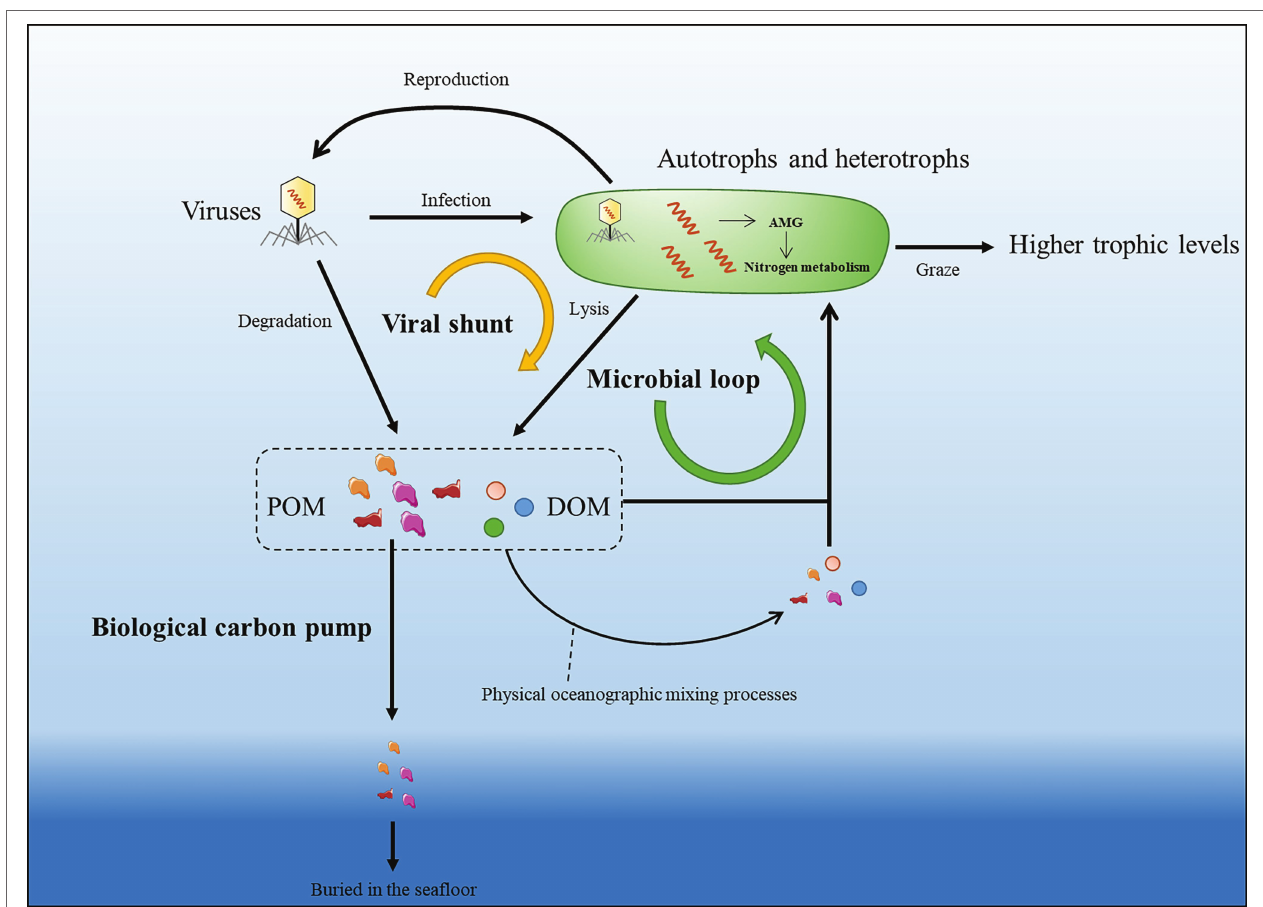
FIGURE 2 | Schematic of viral participation in the marine nitrogen cycle. Virus-mediated lysis of microbial cells (viral shunt) and the degradation of viruses can release particulate organic matter (POM) and Dissolved Organic Matter (DOM) into the microbial loop. POM and DOM can be brought to different water columns through vertical ocean circulation, waves, and eddies pumping while a part of POM can also be sedimented to deep oceans by biological carbon pump. Upon infection, viruses can also regulate hosts’ nitrogen metabolism by encoding relevant auxiliary metabolic genes